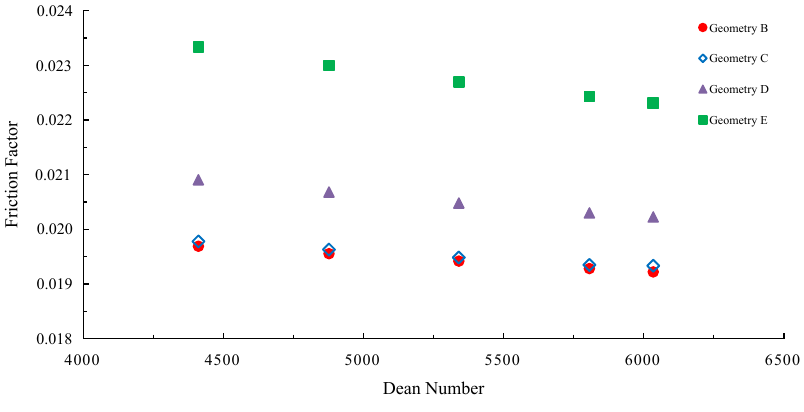
Figure 11. Friction factor vs. Dean number for each one of